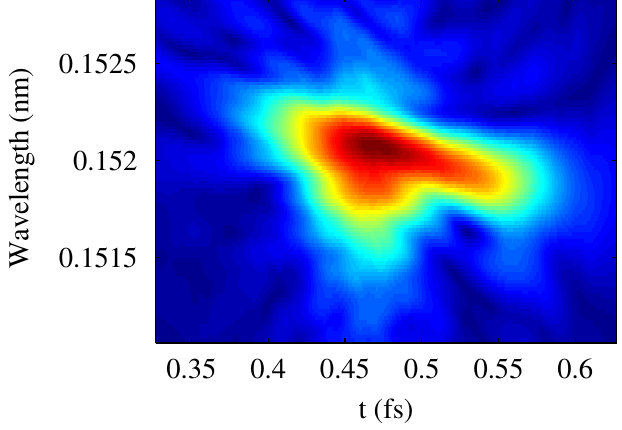
FIG. 8. (Color) False color image of the Wigner transform of the on-axis far field radiation at an undulator length of 50 m.